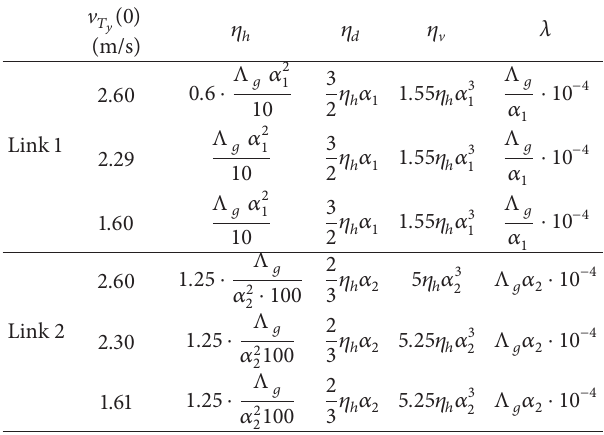
Table 3: The expressions for resistance force coefficients 𝜂 ℎ , 𝜂 𝑑 , 𝜂 V , and 𝜆 .